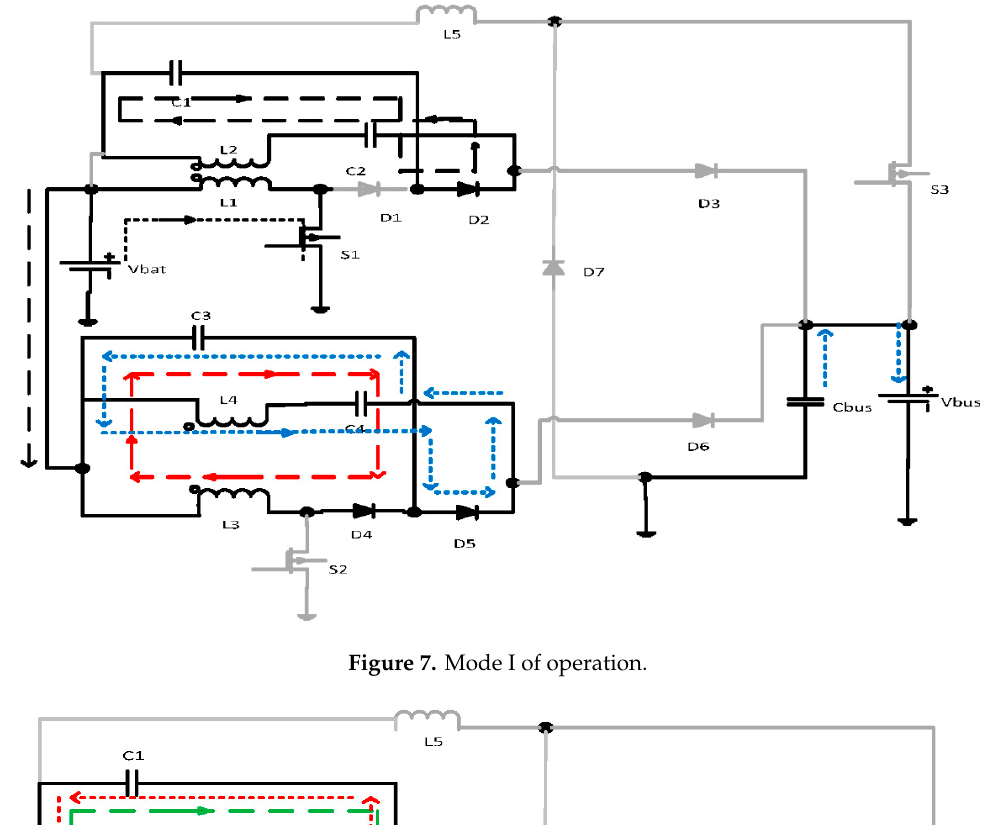
Figure 7. Mode I of operation.